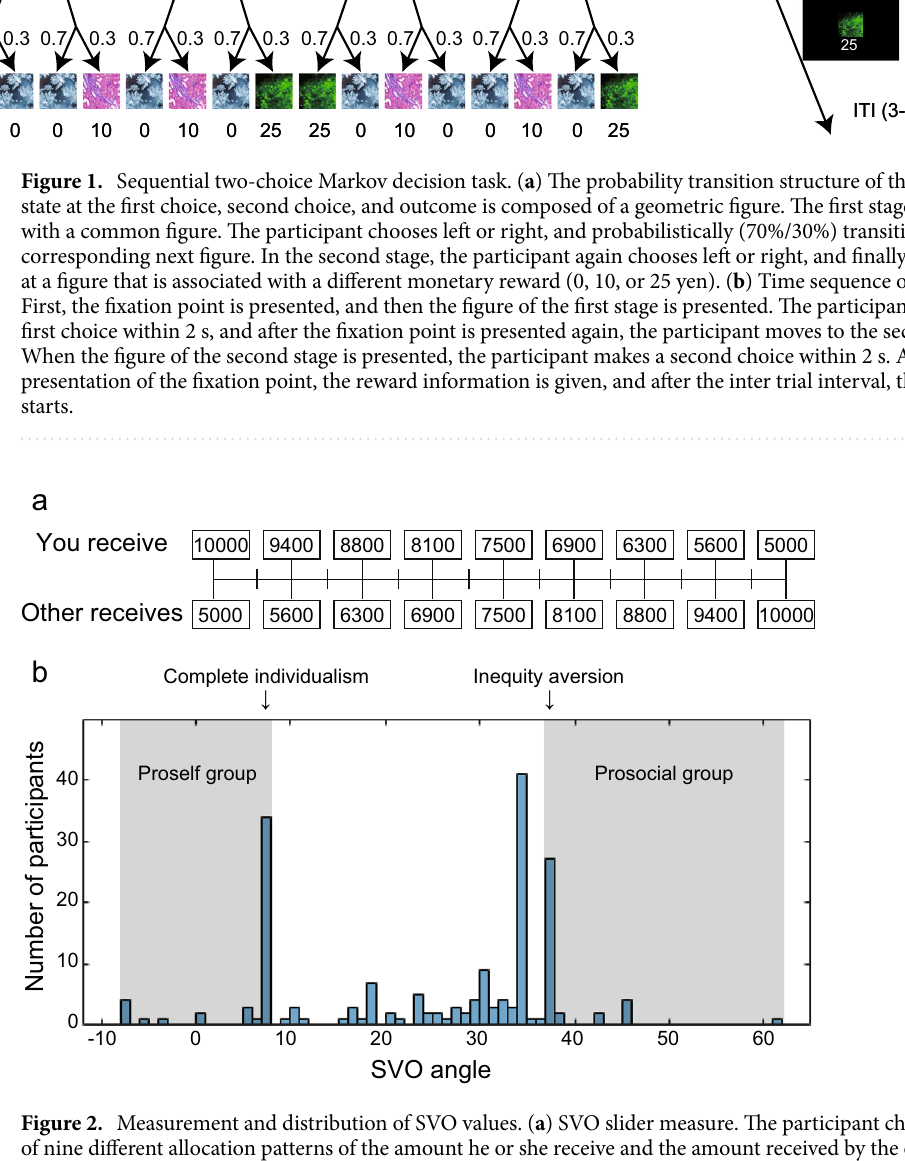
Figure 2. Measurement and distribution of SVO values. ( a ) SVO slider measure. The participant choose one of nine different allocation patterns of the amount he or she receive and the amount received by the other. ( b ) The histogram of SVO scores. In this study, the prosocial group was classified according to the score of inequity aversion or higher, and the proself group according to the score of complete individualism or lower (light gray